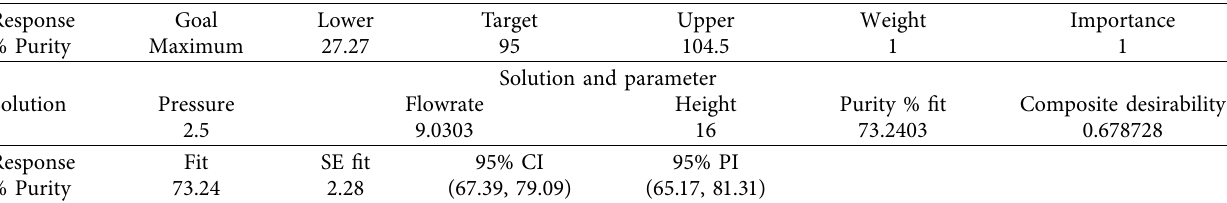
Table 7: Optimal performance of the